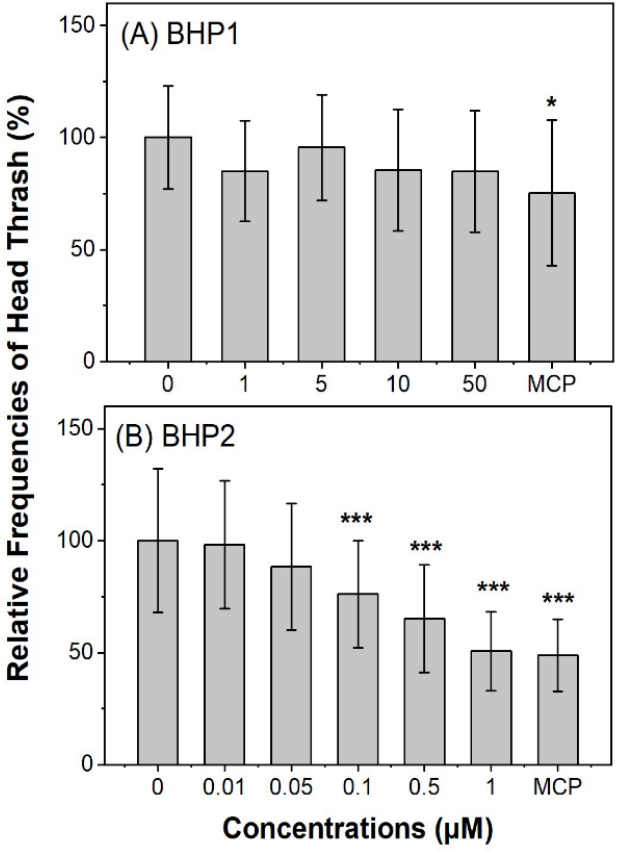
Figure 6. Assessment of neurotoxicity of ( A ) BHP1 and ( B ) BHP2 using C. elegans as the animal model with the frequency of head thrash being used as the endpoint. Monocrotophos (MCP, 75 µ M for BHP1 and 100 µ M for BHP2), a known neurotoxicant, was used as the positive control. The data were normalized and presented as mean ± SD ( n = 15 and 30 for BHP1 and BHP2, respectively; * p < 0.05, *** p < 0.001).